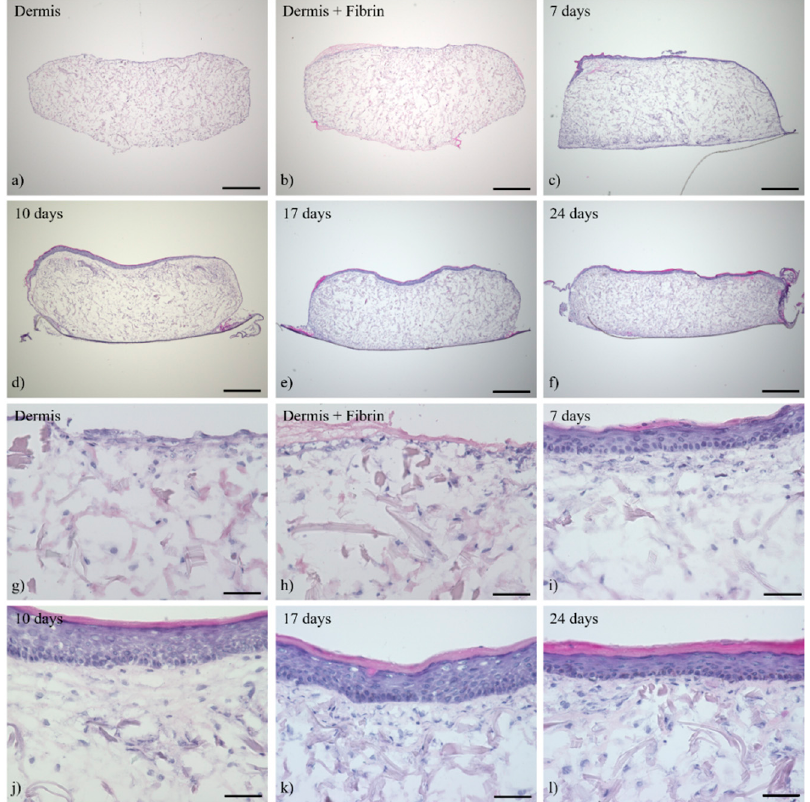
Figure 7. Hematoxylin and eosin (HE) staining of full-thickness skin equivalents (ftSEs). The ftSE morphology was evaluated at different time points. Images show representative cuts of ftSEs of ( a , g ) dermis only, ( b , h ) dermis with fibrin gel added on top, and ( c , i ) after seven days, ( d , j ) 10 days, ( e , k ) 17 days, and ( f , l ) 24 days of ALI culture. The skin equivalents developed a multilayered and stratified epithelium during this 24-day period. ( a – f ) Scale bar: 500 μ m. ( g – l ) Scale bar: 50 μ m.